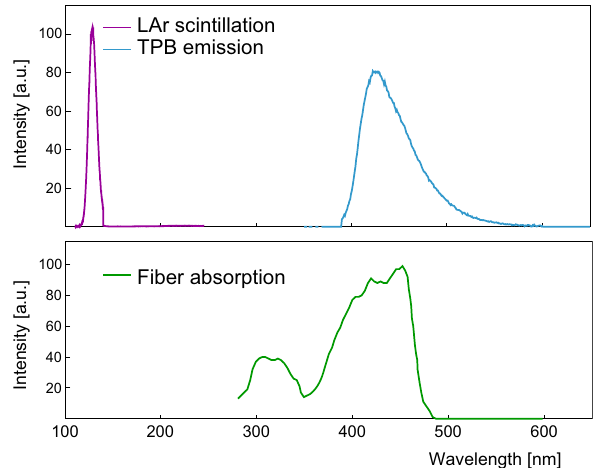
Fig. 1 SpectraofLArVUVscintillation[10],TPBemission(top), and absorption of wavelength-shifting fibers used in LEGEND-200 (bot- tom) [12,13]